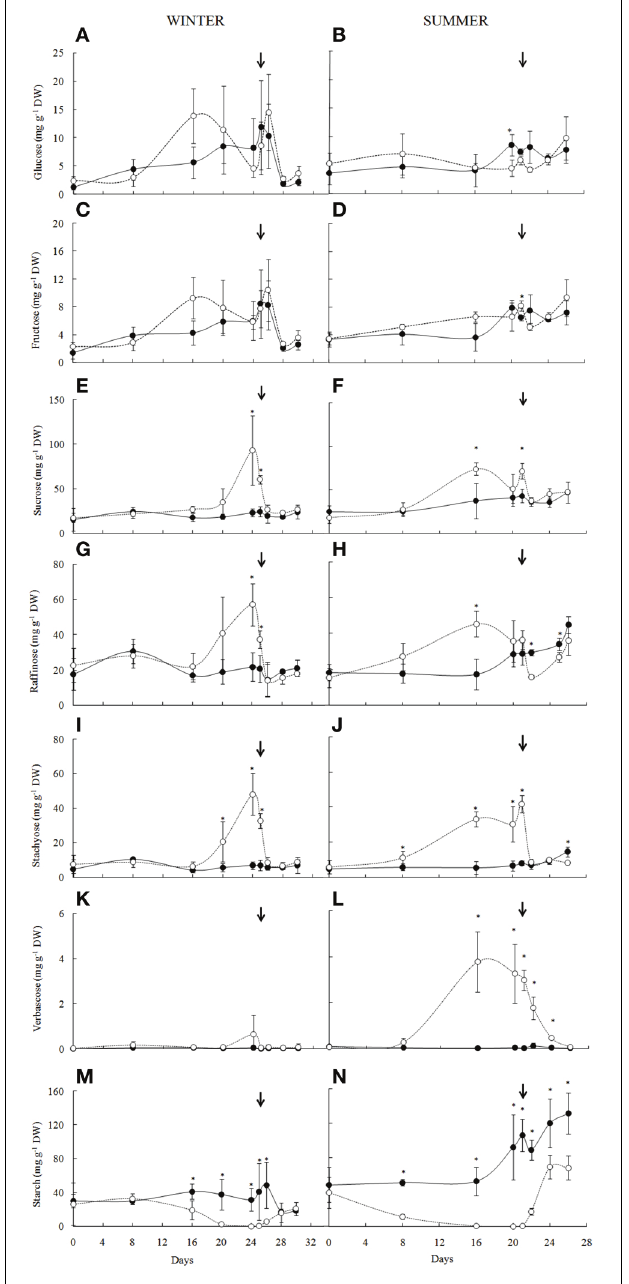
FIGURE 4 | Carbohydrates analysis of the Barbacenia purpurea leaves during dehydration and rehydration. Glucose (A,B) , fructose (C,D) , sucrose (E,F) , raffinose (G,H) , stachyose (I,J) , verbascose (K,L) , and starch (M,N) in leaves of daily watered plants (control group— • ) and plants under water suppression (treatment group— ◦ ) in winter (left side) and summer (right side) season. The narrow indicates the day of rehydration. ∗ Significant difference between treatments at P < 0 . 05 ( n = 3 ± SD